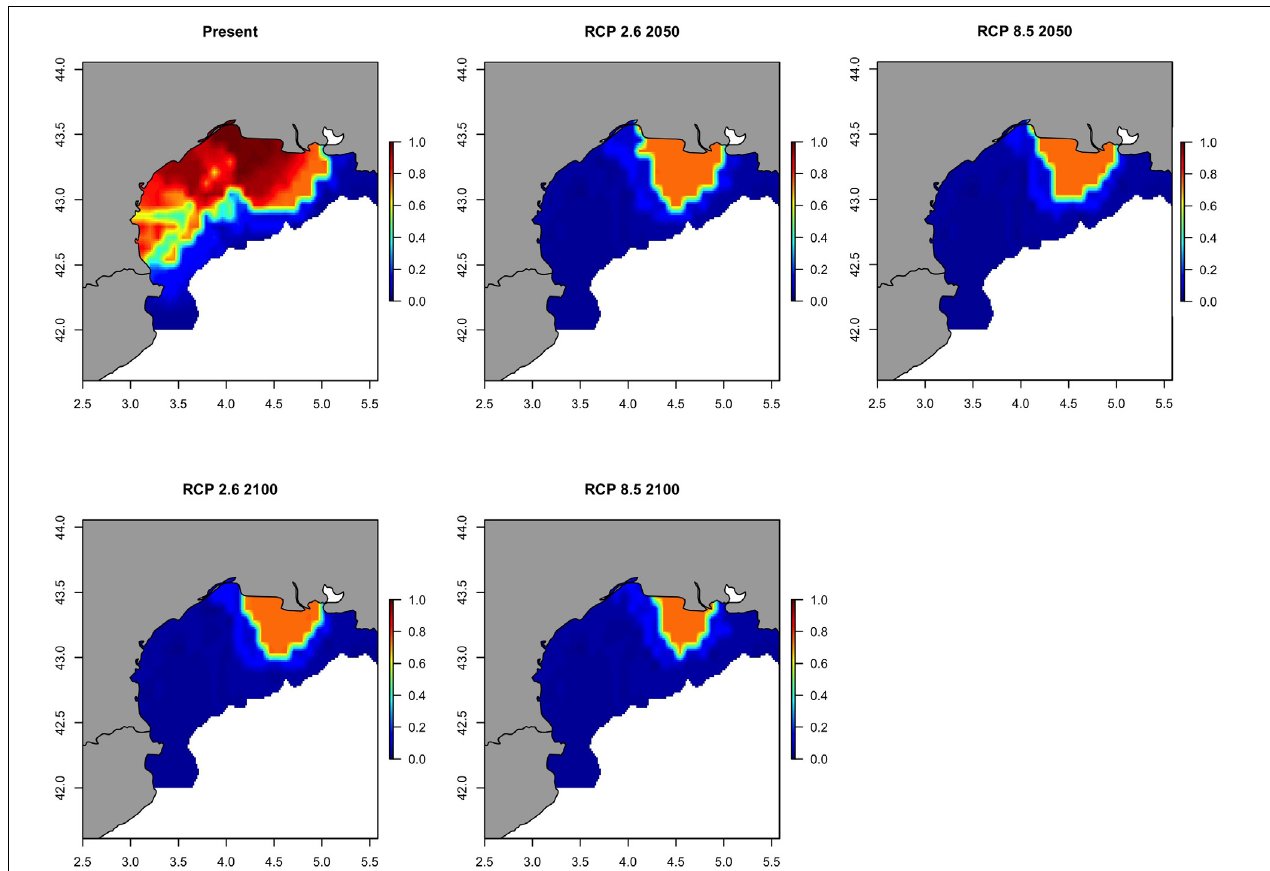
FIGURE 10 | Predicted probability of occurrence of the European sardine ( Sardina pilchardus ) in Geographical Sub-Area 07 for the present situation and using IPCC pathway scenarios obtained with RAC-BRT models.